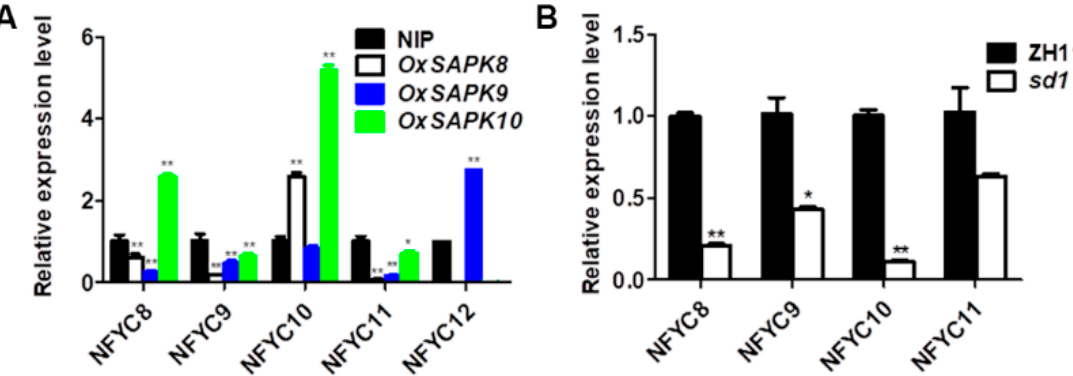
Figure 3. ( A ) The expression level of NFYC8 to NFYC12 in the seeds of wild-type-NIP, OxSAPK8 , OxSAPK9, and OxSAPK10 mutants that germinated for 6 h. ( B ) The expression level of NFYC8 to NFYC11 in the seeds of wild-type-ZH11 and sd1 mutant that germinated for 6 h (* p < 0.05, ** p < 0.01 by two-tailed Student’s t -test).